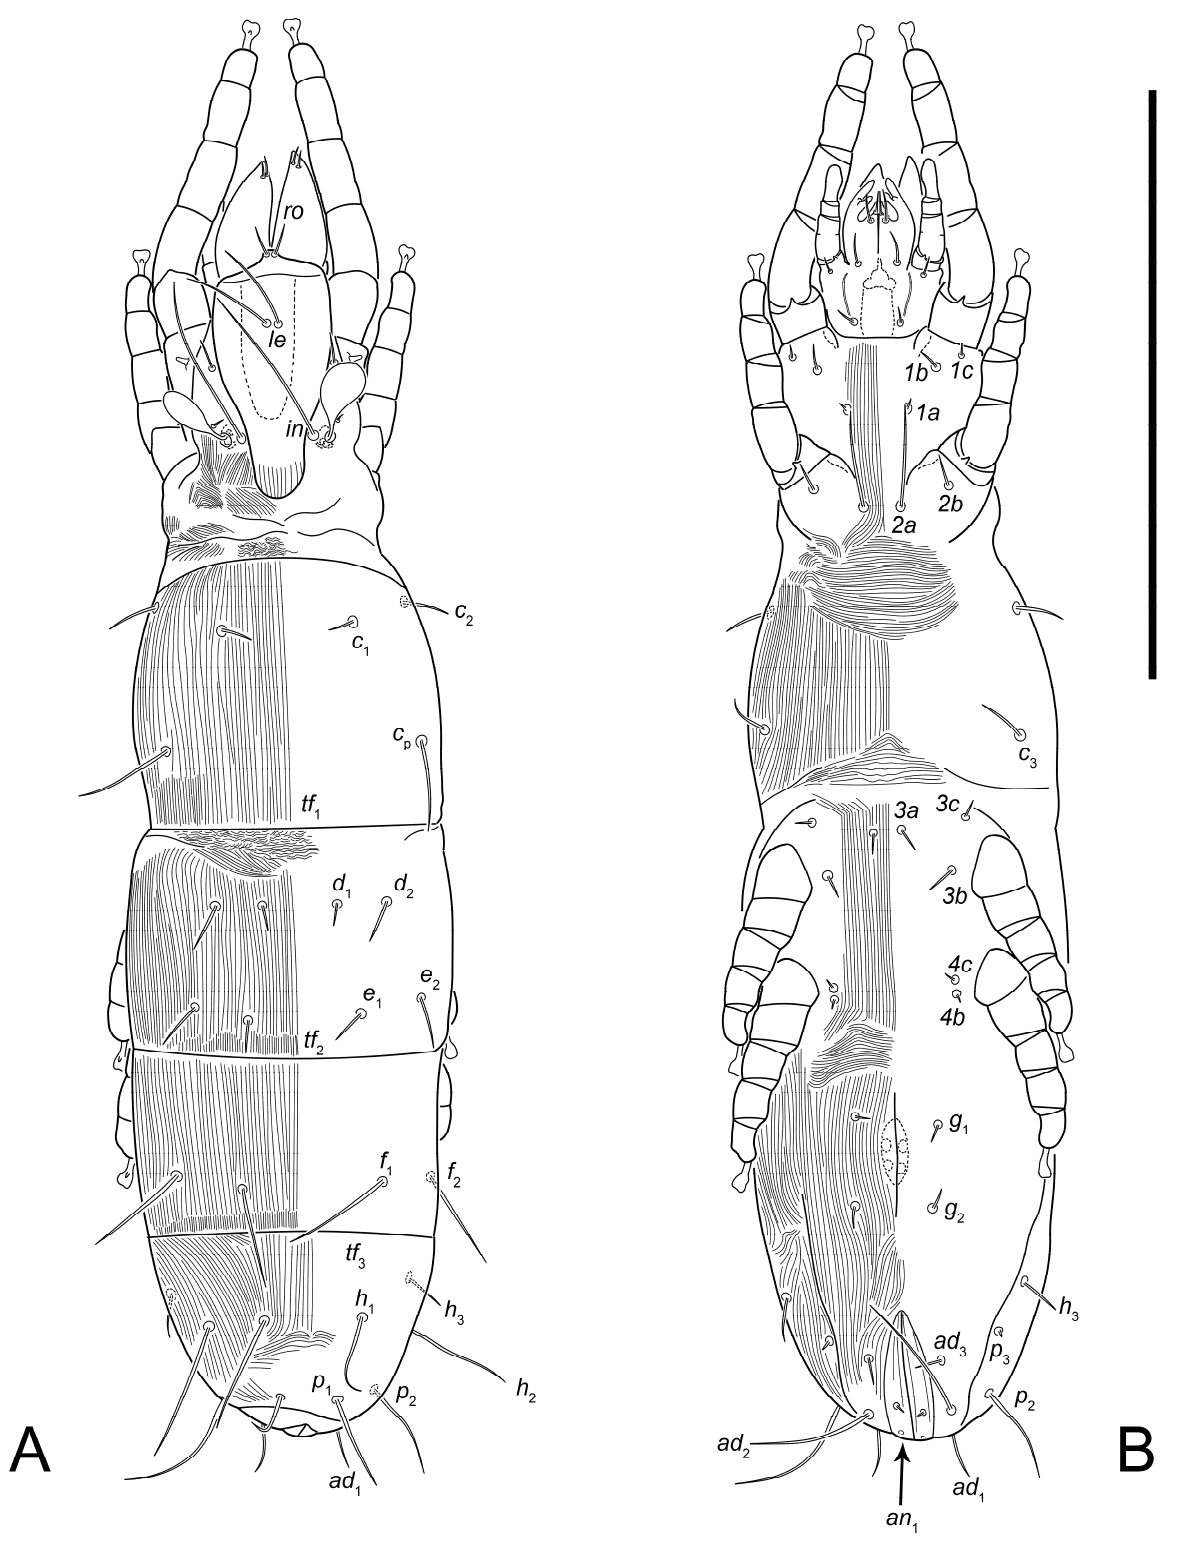
Figure 9. Paralycus daeira sp. n., deutonymph: ( A )—dorsal view; ( B )—ventral view. Scale bar 100 µm.